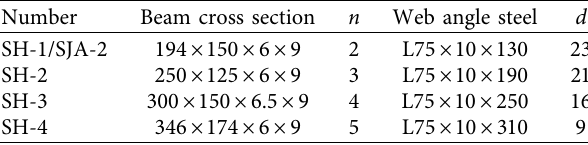
Figure 18: Sensitivity coefficients for 5% and 20% variation ranges. Table 6: Size and information of the beam height series model